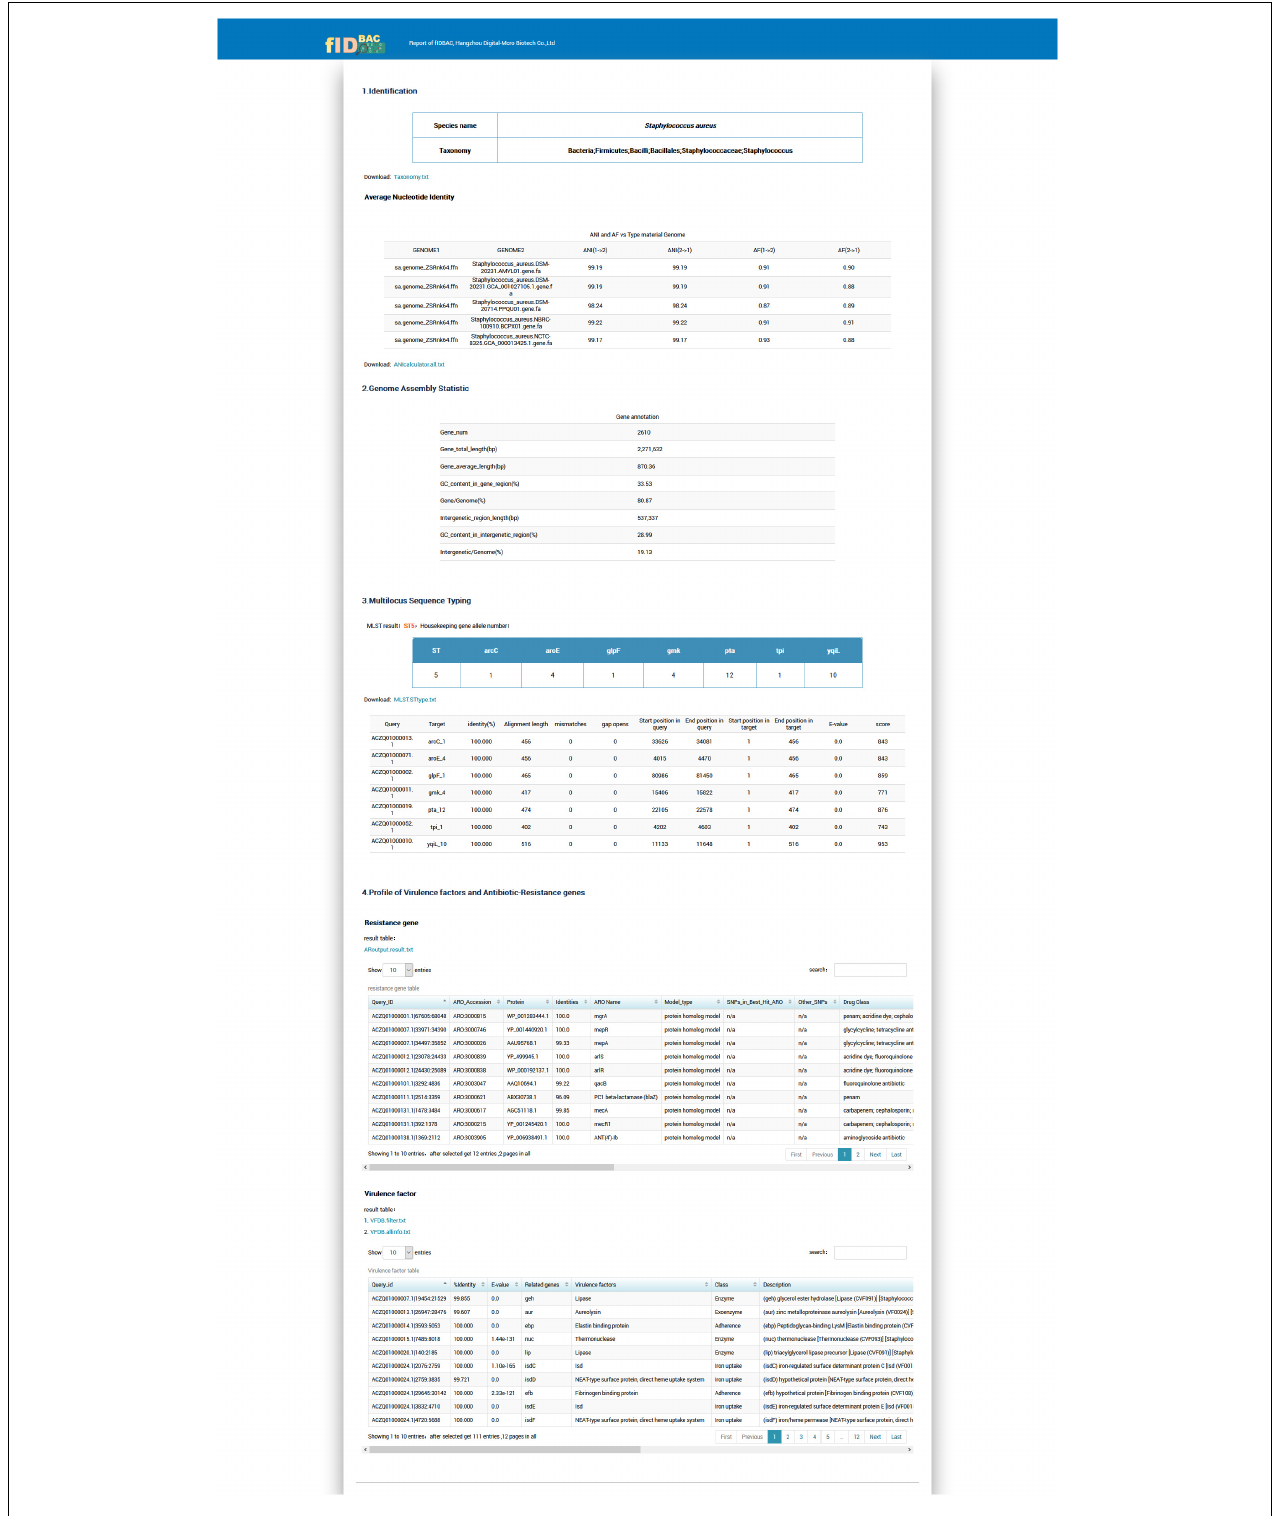
FIGURE 6 | Screenshot of the example report by the full fIDBAC